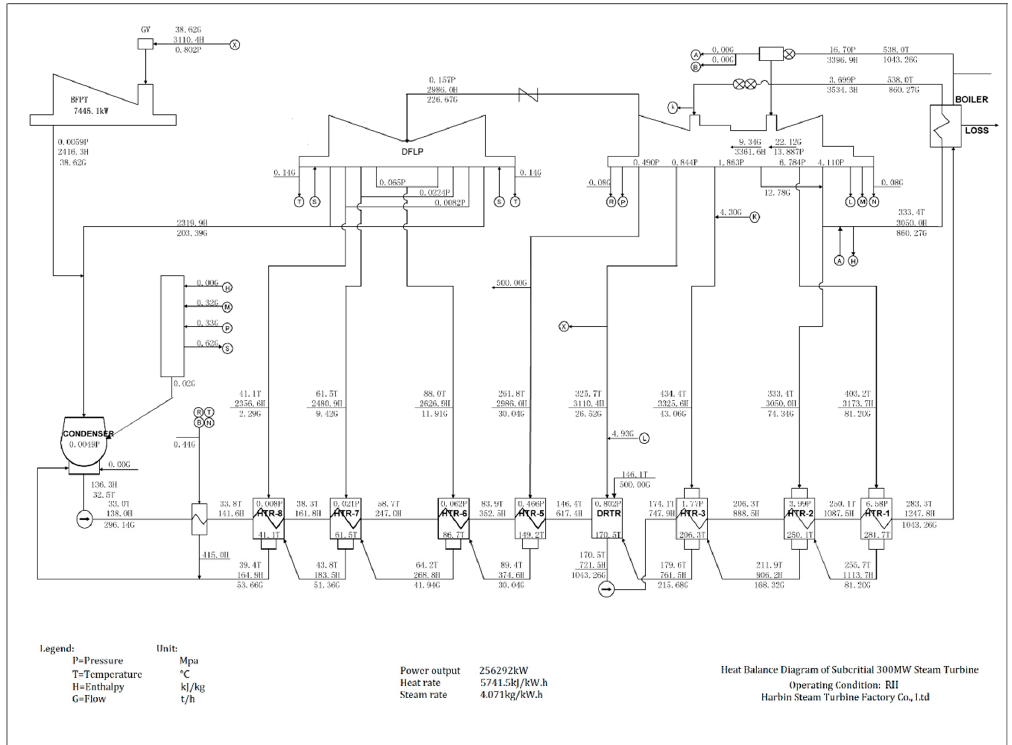
Figure A2. Heat balance diagram in rated heating (RH) condition. Table A1. Performance parameters of boiler (boiler maximum continuous rating ( BMCR ); turbine rated load (TRL); turbine heat acceptance (THA)).